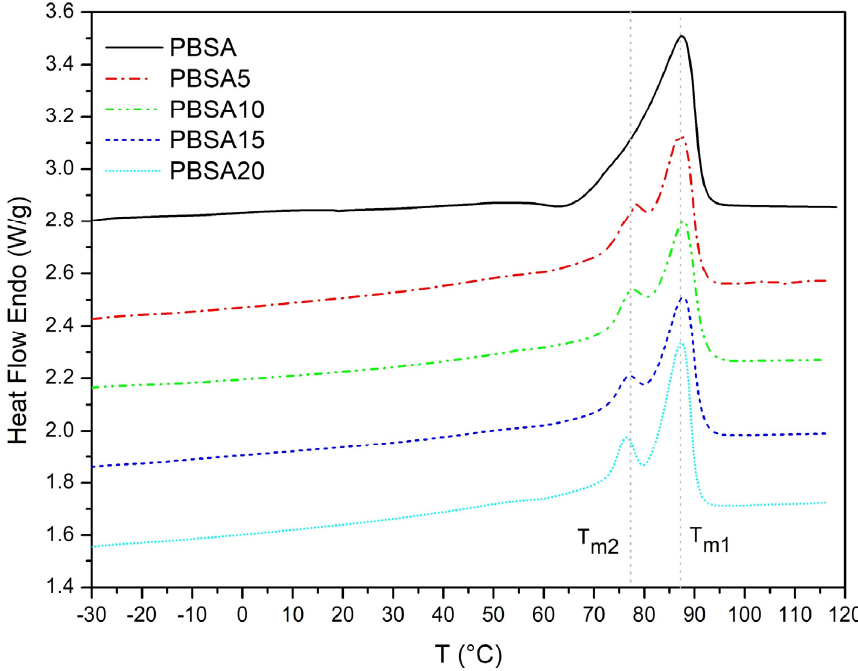
Figure 2. DSC curves of PBSA and PBSA/BC composites during the 2 nd heating run at 10 °C/min. The degree of crystallinity (X C ) of PBSA and PBSA/BC composites determined by Equation (1) remains almost constant with the increase in BC content (from 34.4 to 35.8%, Table 2 and Figure 3). These crystallinity values align with those reported in similar stud- ies using the same type of PBSA [13,34]. Although the addition of BC did not affect the total crystallinity X C, this value is calculated as a sum of two endothermic peaks: a small shoulder peak at about 76–78 °C (T m2 ), followed by a large peak at about 87-88 °C (T m1 ). The shoulder peak is not present in the pure PBSA and only appears in the PBSA compo- sites. PBSA/BC composites maintain the same level of total crystallinity (X C ) equal to the pure polymer; however, the proportion of crystallinity estimated by the areas under the peaks associated with the two endothermic events changes slightly with BC concentra- tion; in particular, the higher the BC content, the greater is the crystallinity associated with the shoulder peak (X C2 ), and, in turn, the smaller the crystallinity associated with the large peak (X C1 ). Table 2. Crystallinity degrees of PBSA and PBSA/BC composites. Sample